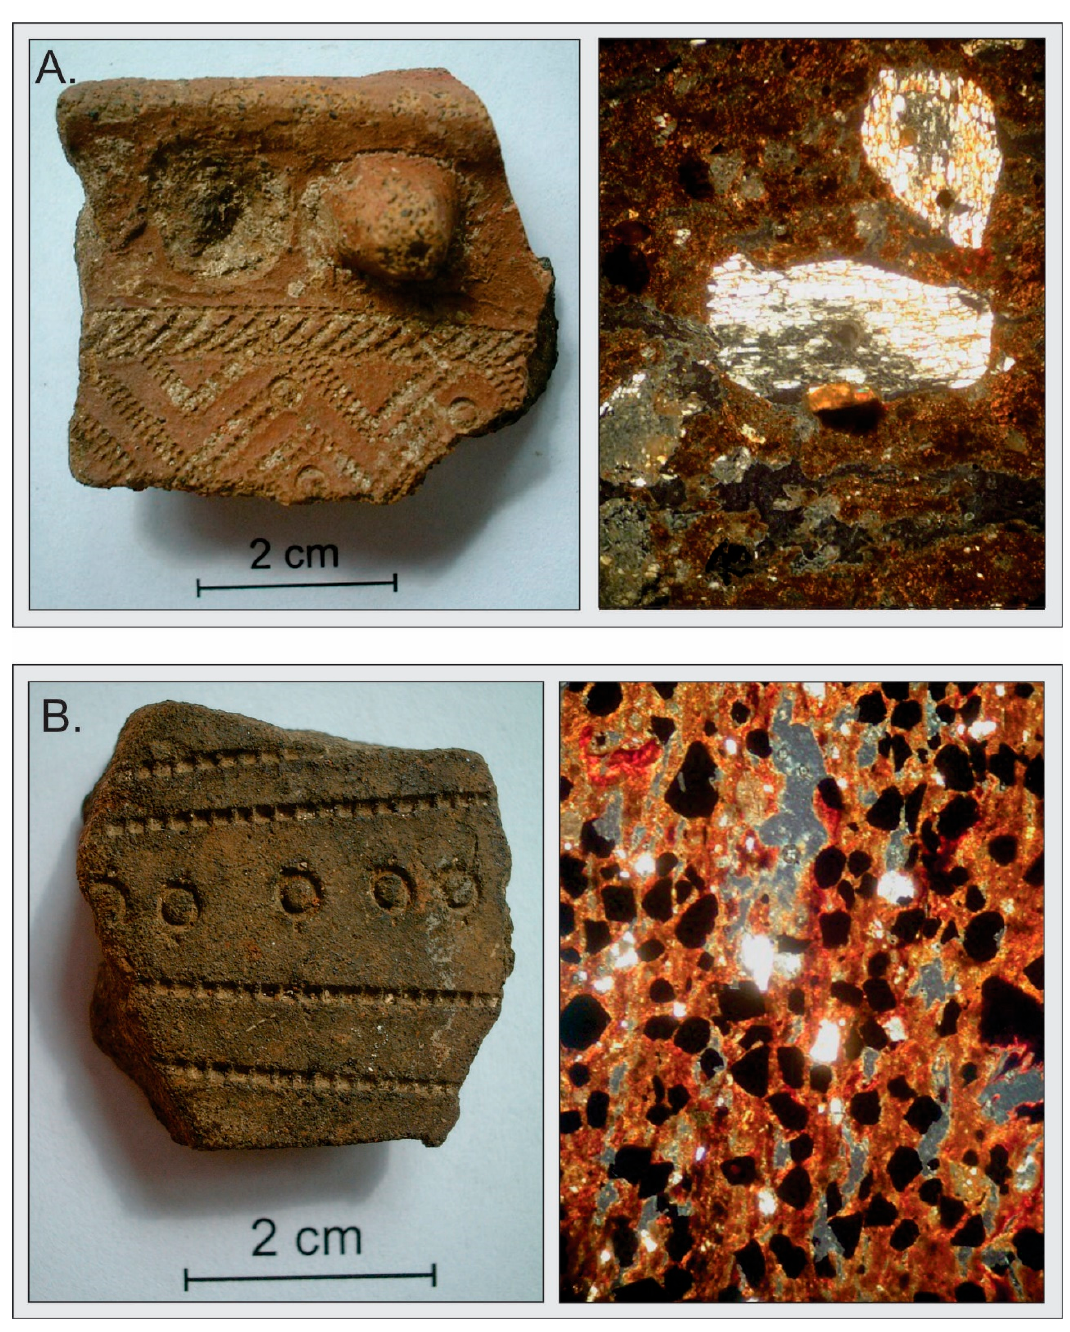
Figure 3. Examples of Lapita (dentate-stamped) potsherds from Naitabale (Moturiki Island) and representative details of their mineralogy (under crossed polarized light). ( A )—Sherd 56 (Pit R2, − 65 cm) has a standard temper, manufactured locally using volcanic sands dominated by clinopyroxene (63%), hornblende (12%) and plagioclase (11%); magnification 10×. ( B )—Sherd 23 (Pit P3, − 145 cm) included 23 grains (3% of total counted) of quartz and is interpreted as exotic (local variant of quartzose temper); magnification 4×. Full details in Kumar [18] .